Question: Give a one-sentence summary of this figure.
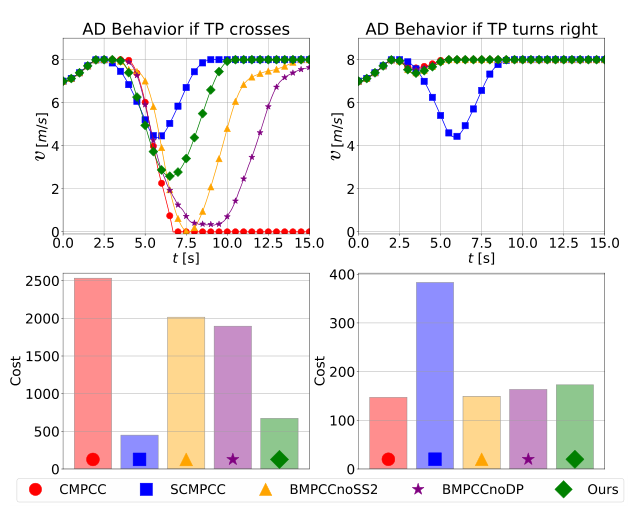
Answer: Qualitative comparison of the performance of our approach and the Baselines in the traffic intersection scene